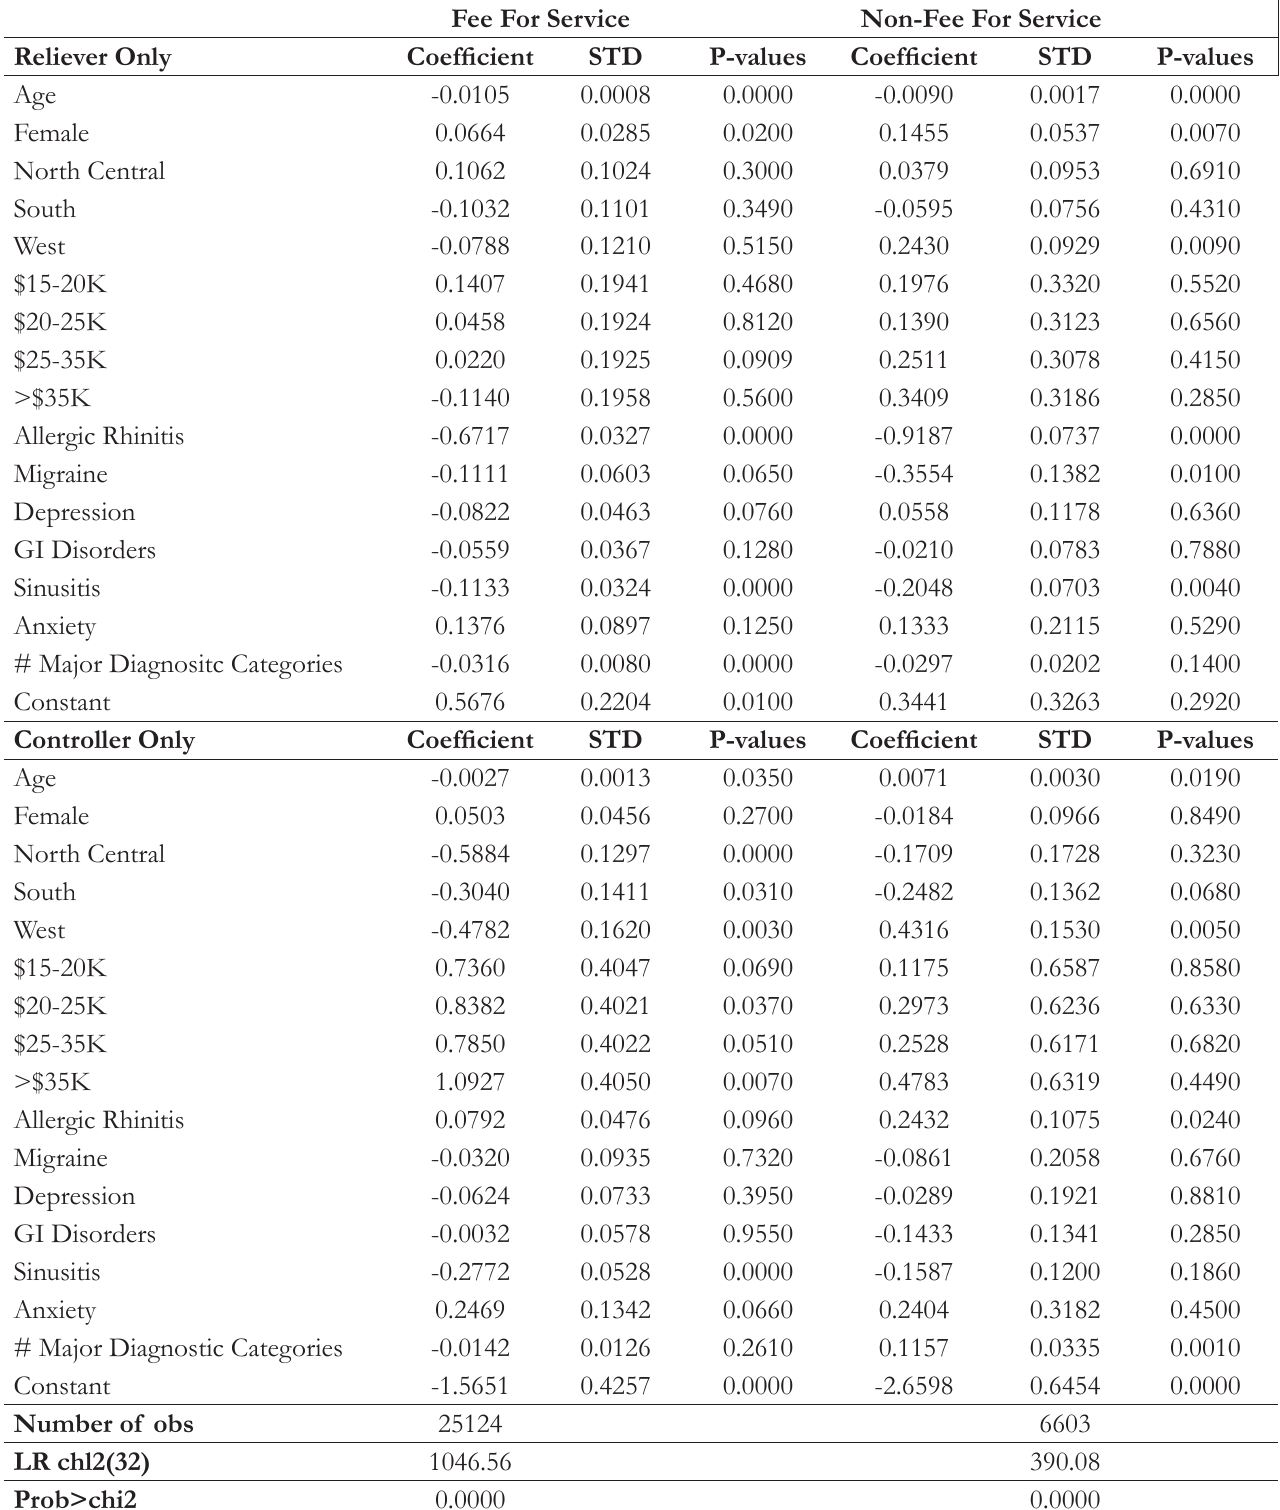
Table 2. Multinomial Logit